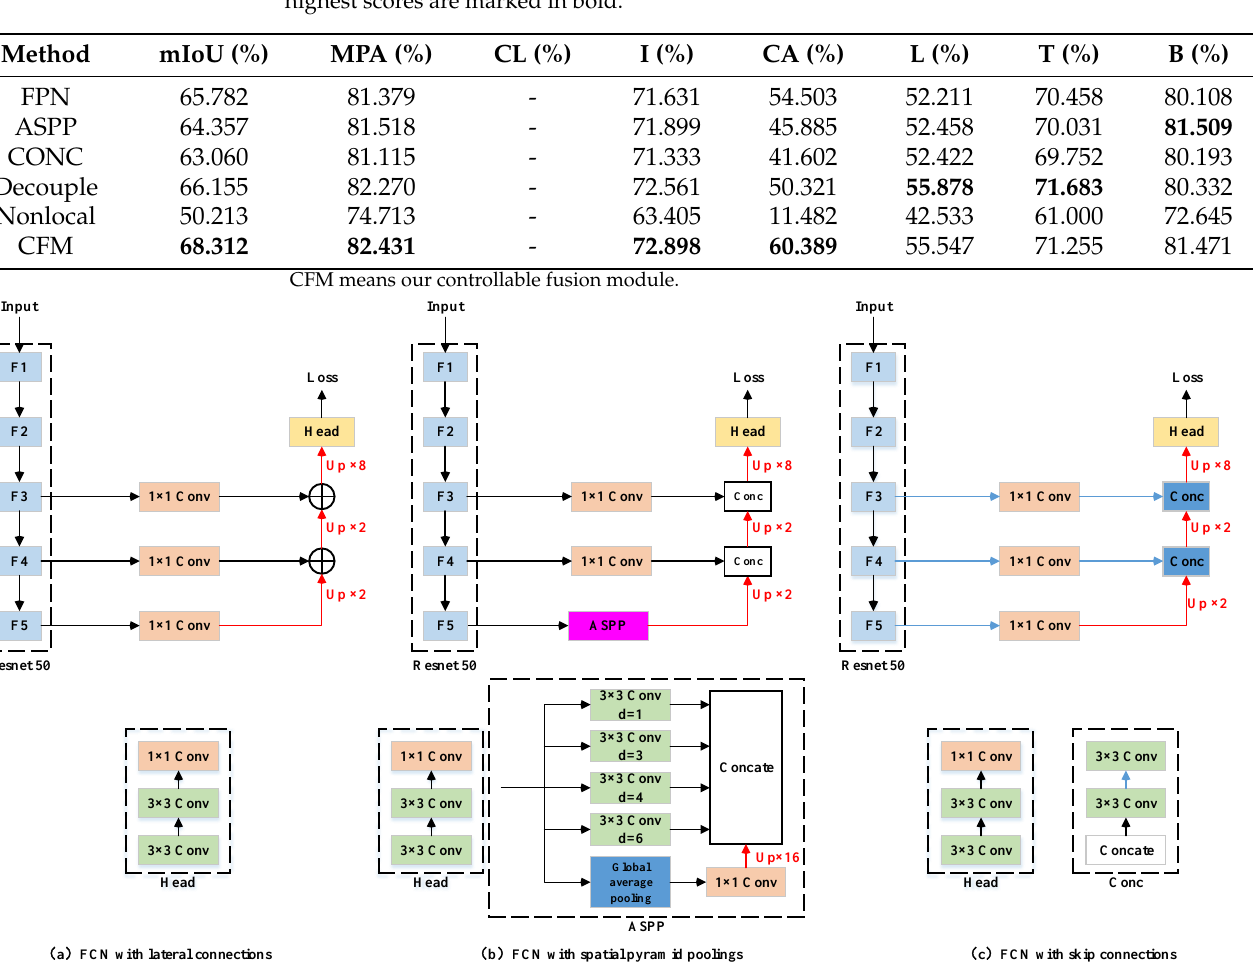
Figure 8. FCN with different fusion modules. ( a ) FCN with lateral connections. ( b ) FCN with spatial pyramid poolings. ( c ) FCN with skip connections. The red lines represent